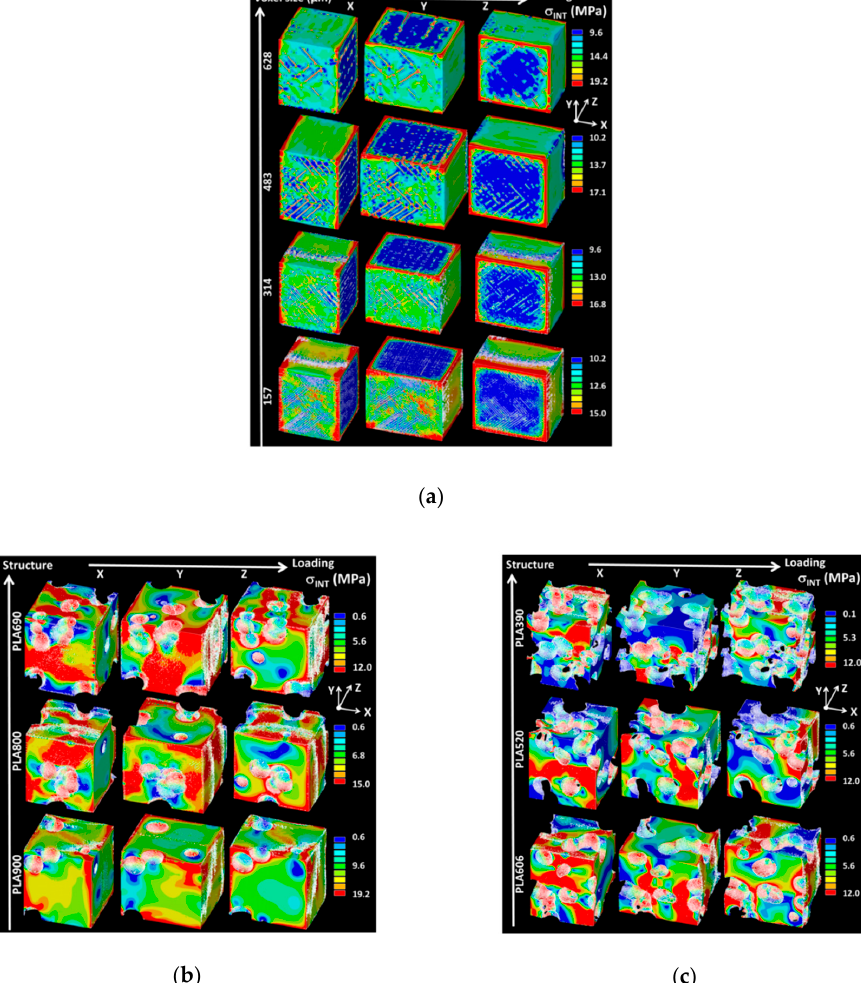
Figure 7. Finite element results ( a ) Stress intensity ( σ INT ) counterplots as a function of loading direction and voxel size for a fully dense configuration of 3D printed PLA. Stress intensity ( σ INT ) counterplots as a function of loading direction of 3D printed PLA cellular structures exhibiting ( b ) low ( < 40%) and ( c ) large ( > 30%) porosity contents.